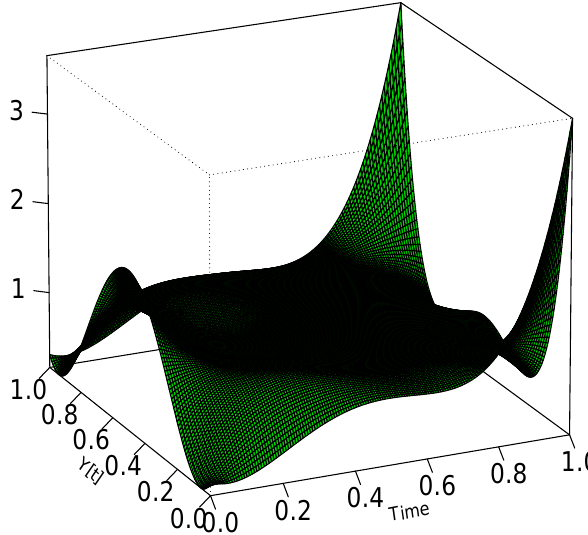
Figure 6. LP copula diagnostic for detecting non-stationarity in S&P 500 return